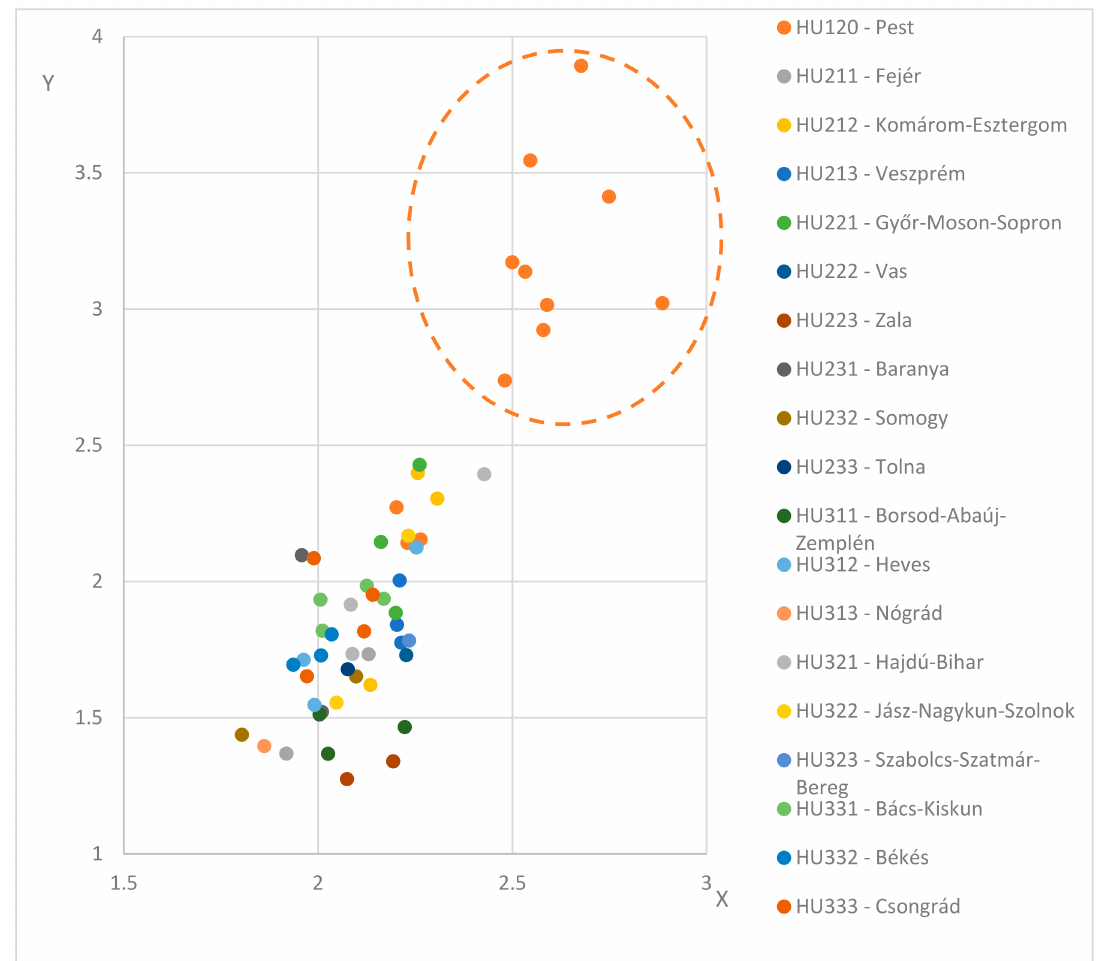
Figure 6. The number of persons per household and electrical energy expended by amount. Legend: Axle Y = The amount of energy provided to households (1000 kWh/household); Axle X = The number of dwellers per household (person/household) (City: n = 46, country (NUTS 3) n =